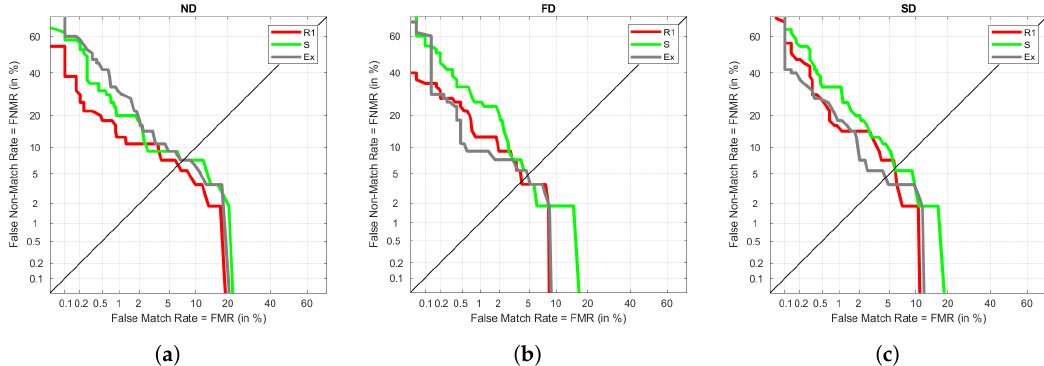
Figure 9. Results for every test set using ( a ) ND, ( b ) FD, and ( c ) SD signals with 50% of R2 as